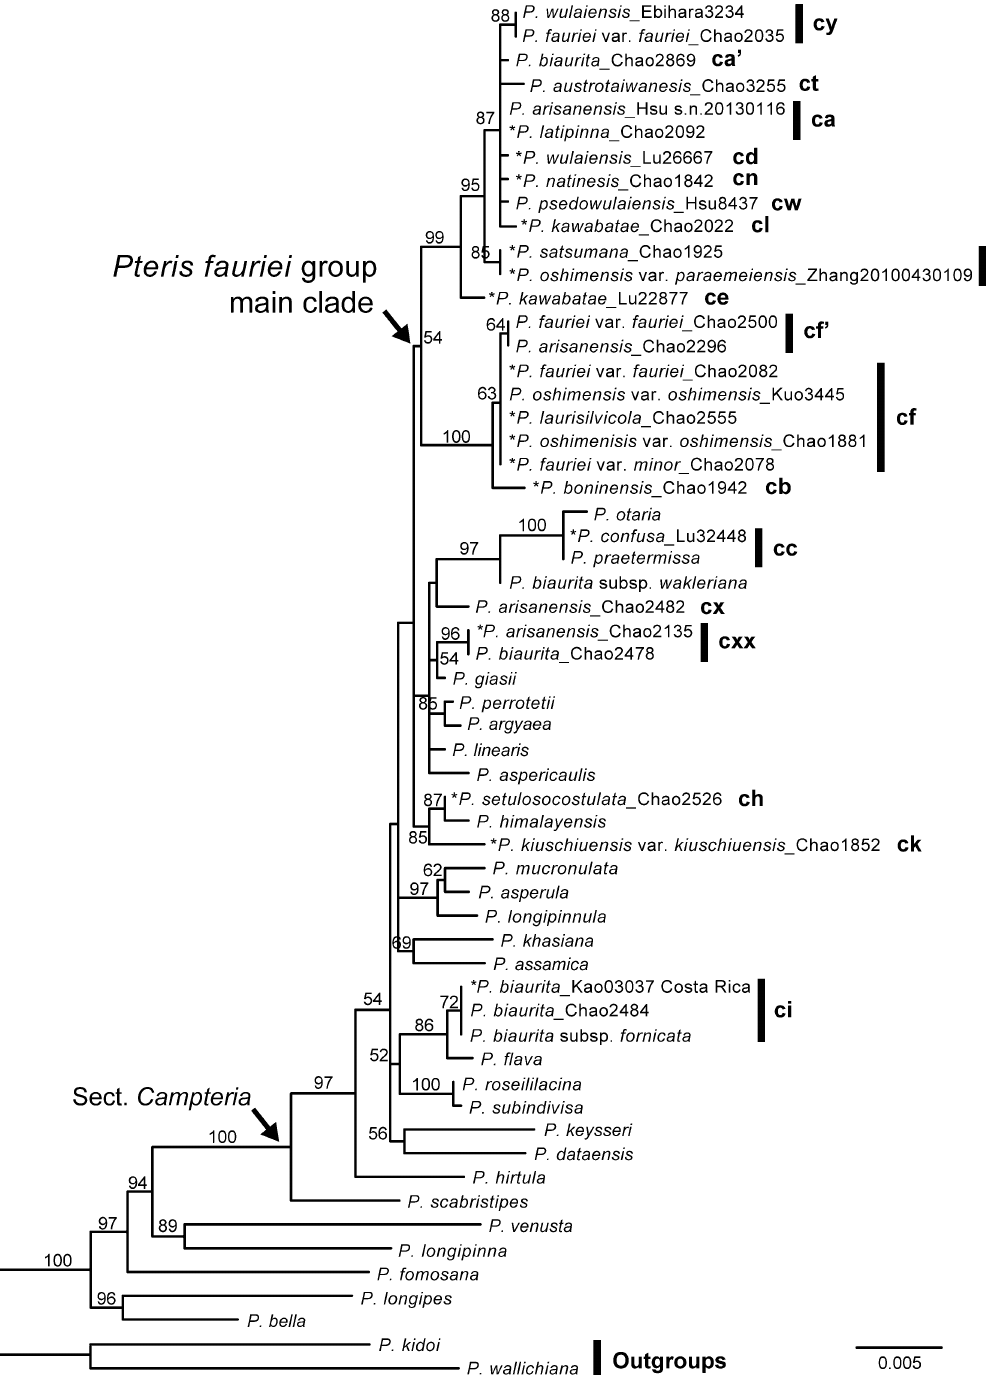
Figure 1. Chloroplast DNA phylogeny of haplotypes of Pteris fauriei group. ML bootstrap support values are indicated on each branch. * indicates the samples with the greatest morphological similarity to corresponded type